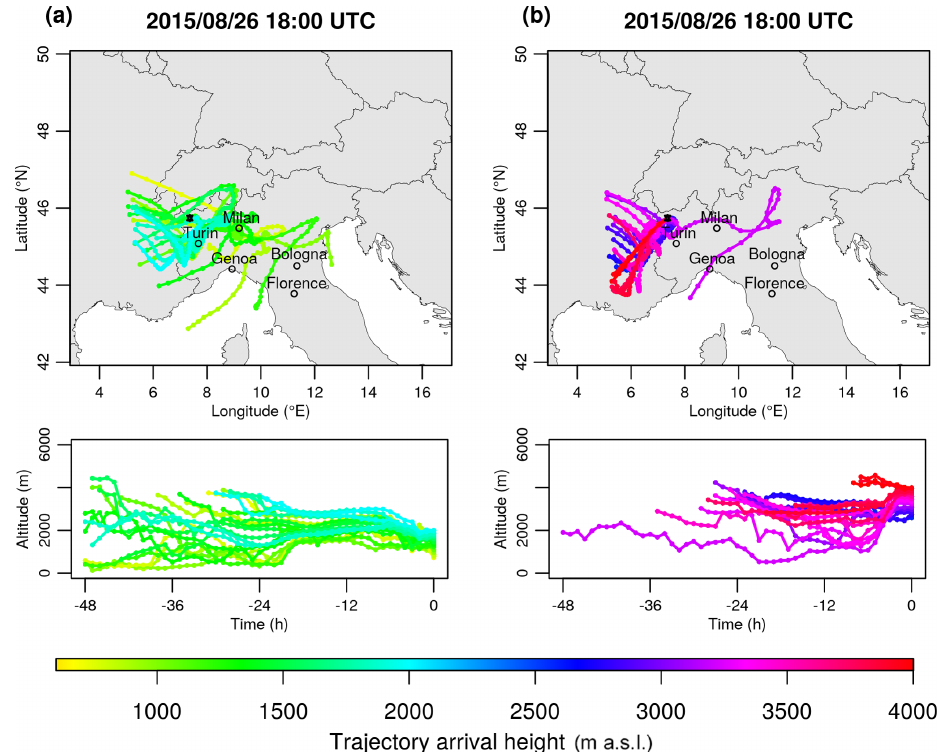
Figure 5. The 48h back trajectories ending at Aosta–Saint-Christophe on 26 August 2015 at 18:00UTC at altitudes lower than 2000ma.s.l. (a) and higher than 2500ma.s.l. (b) . The trajectories are cut at the border of the COSMO model. The colour scale repre- sents the back-trajectory arrival height. Corresponding altitudes of the back trajectories vs. time are reported in the bottom panels. The dots along each trajectory mark a 1h step and the black star indicates the trajectory arrival point (Aosta–Saint-Christophe). A more complete sequence for the episode is shown in Fig.